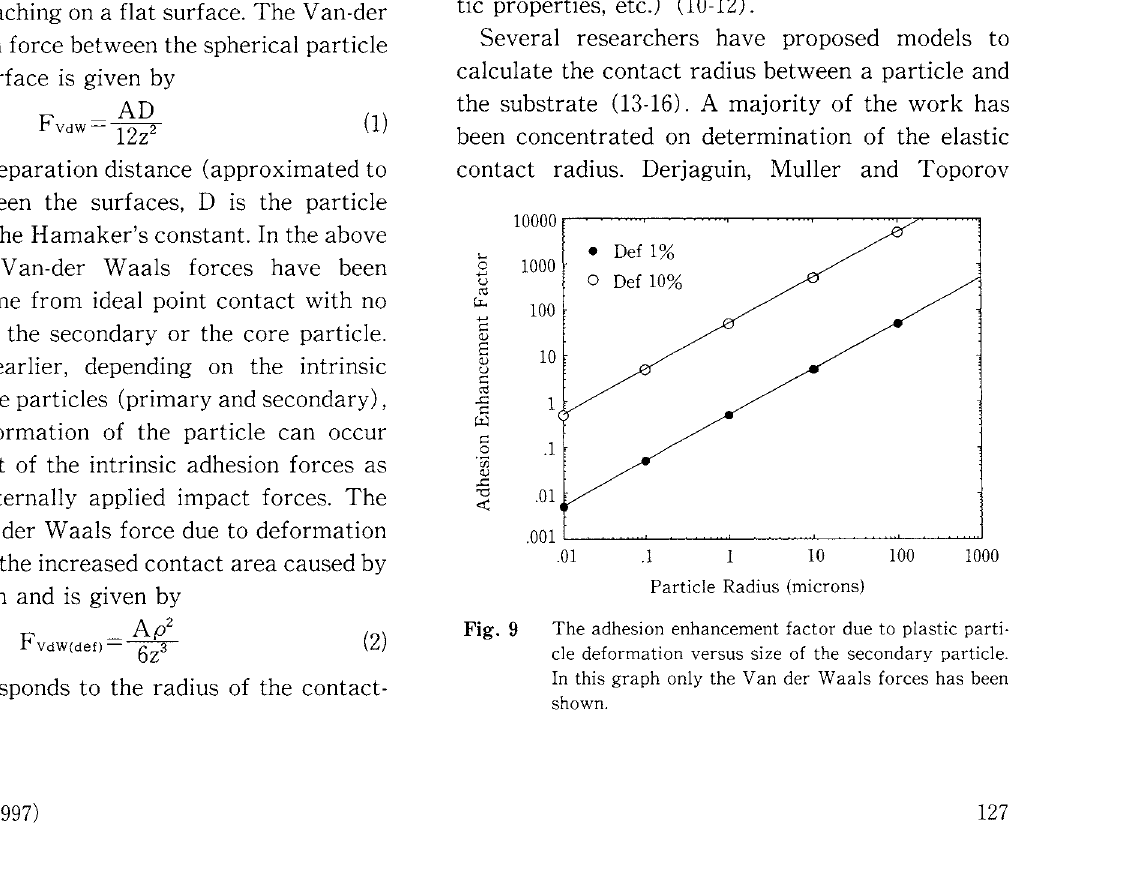
The adhesion enhancement factor due to plastic parti· cle deformation versus size of the secondary particle. In this graph only the Van der Waals forces has been